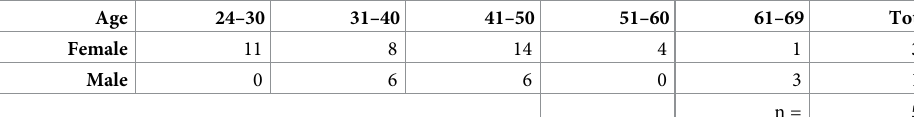
Table 2. Gender and age distribution of participants.